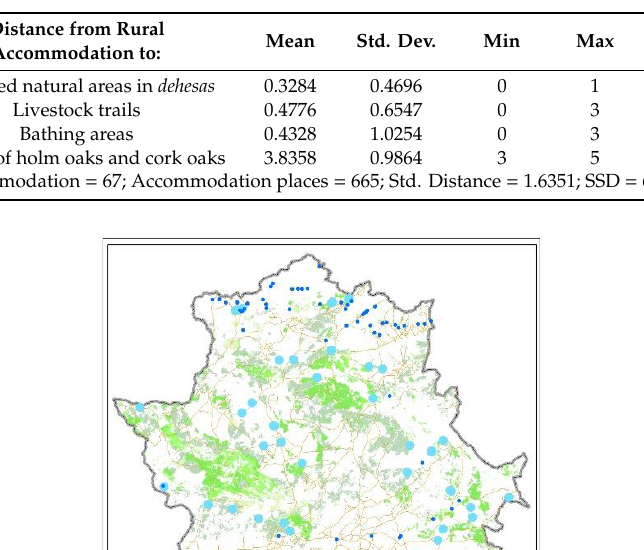
Table 8. Overall variable statistics (Group 1).